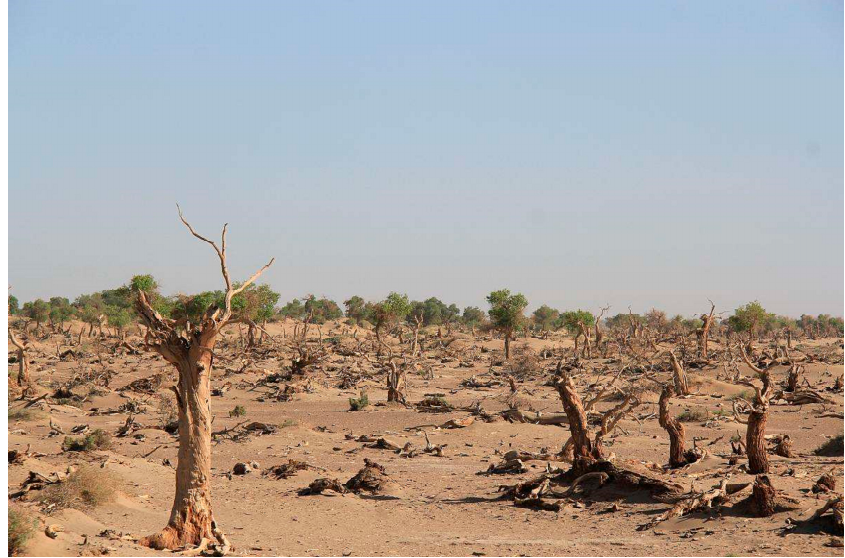
Figure 2. Desiccation and desertification of Tugai forests [36].